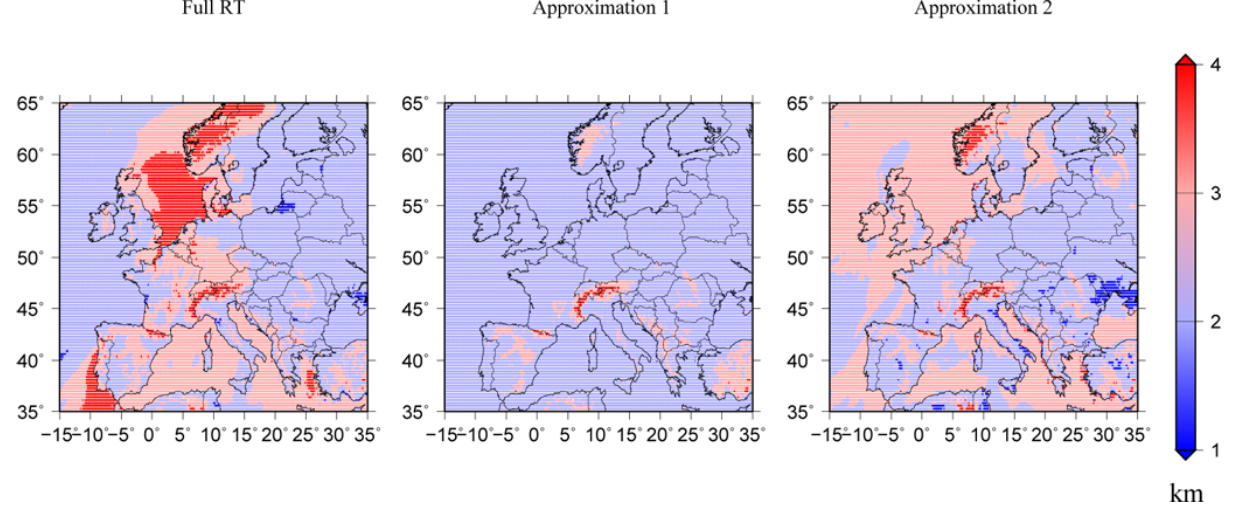
Fig. 7. Same as Fig. 6 but for the surface-3km ozone columns.